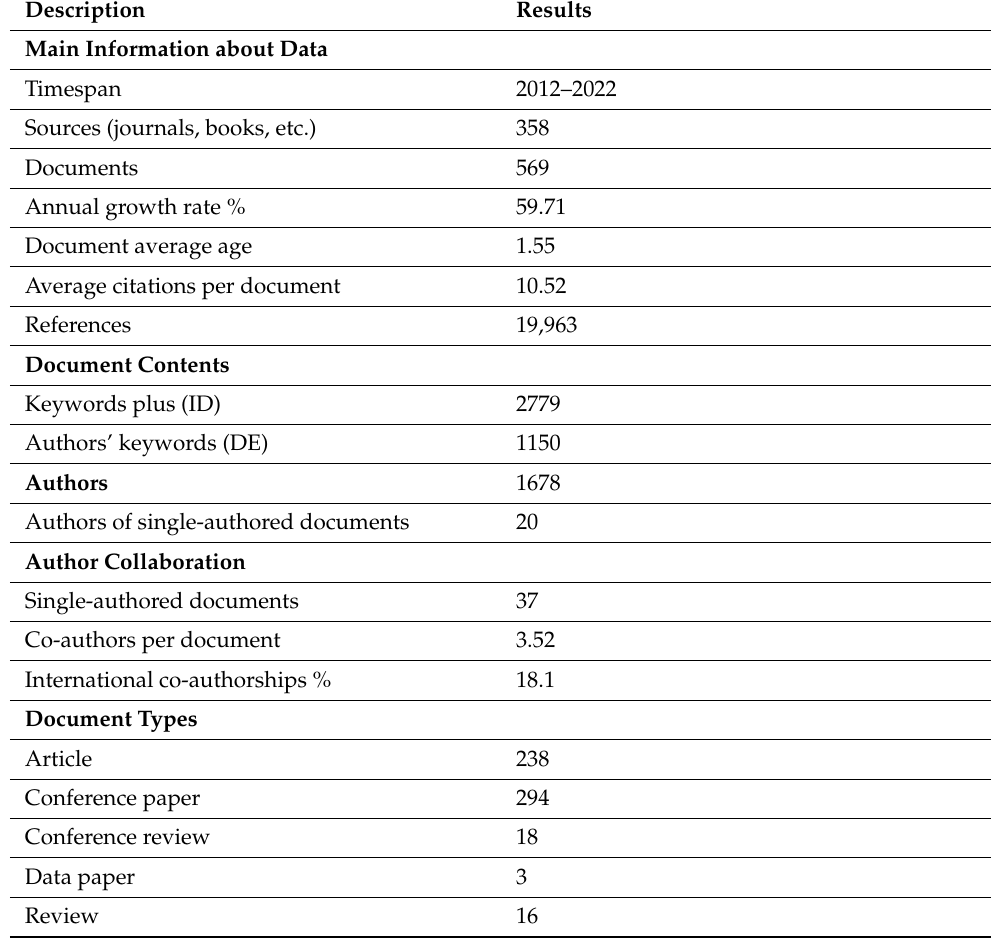
Table 1. Dataset